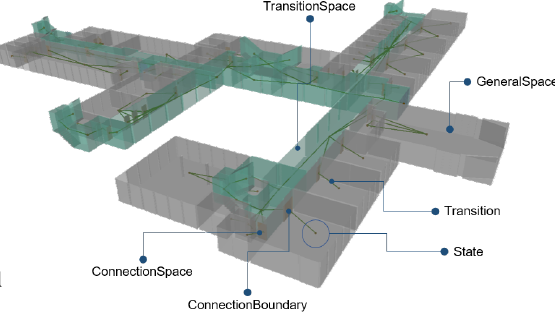
Figure 11. Ground floor IndoorGML model of the Agricultural Sciences